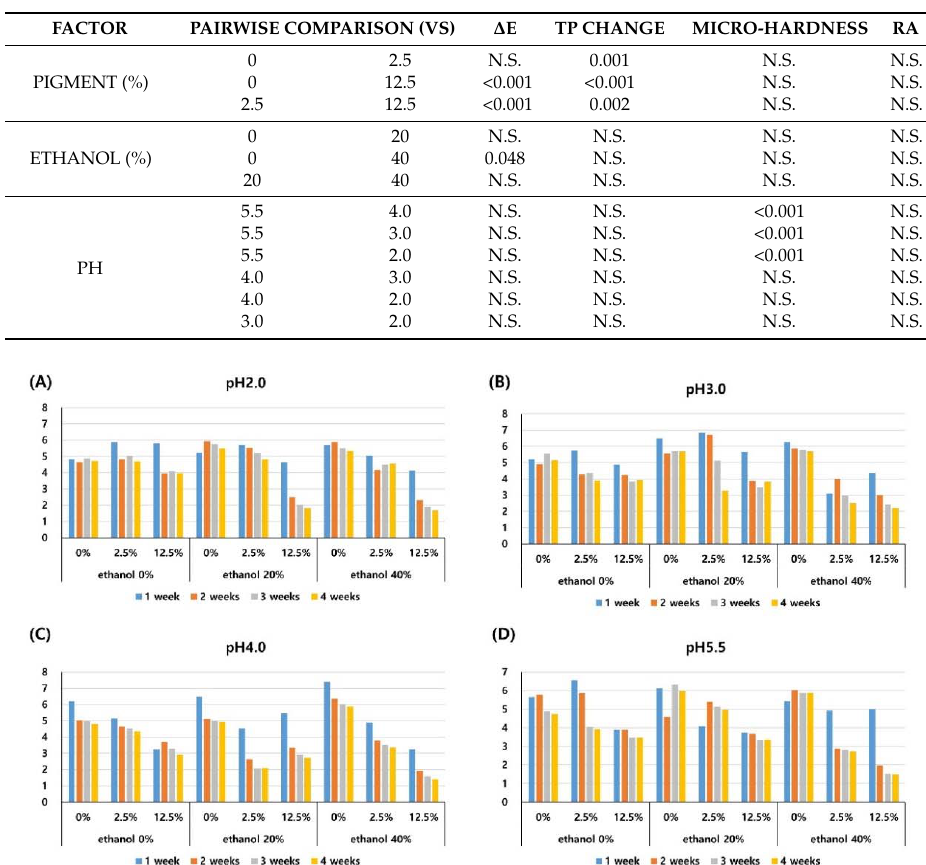
Table 2. P-values from repeated measures of analysis of variance (ANOVA) carried out according to one of three factors (pigment concentration, ethanol concentration, or pH of storage solution) and time (1-, 2-, 3-, and 4-weeks). N.B.: There was no statistical significance ( P > 0.05).